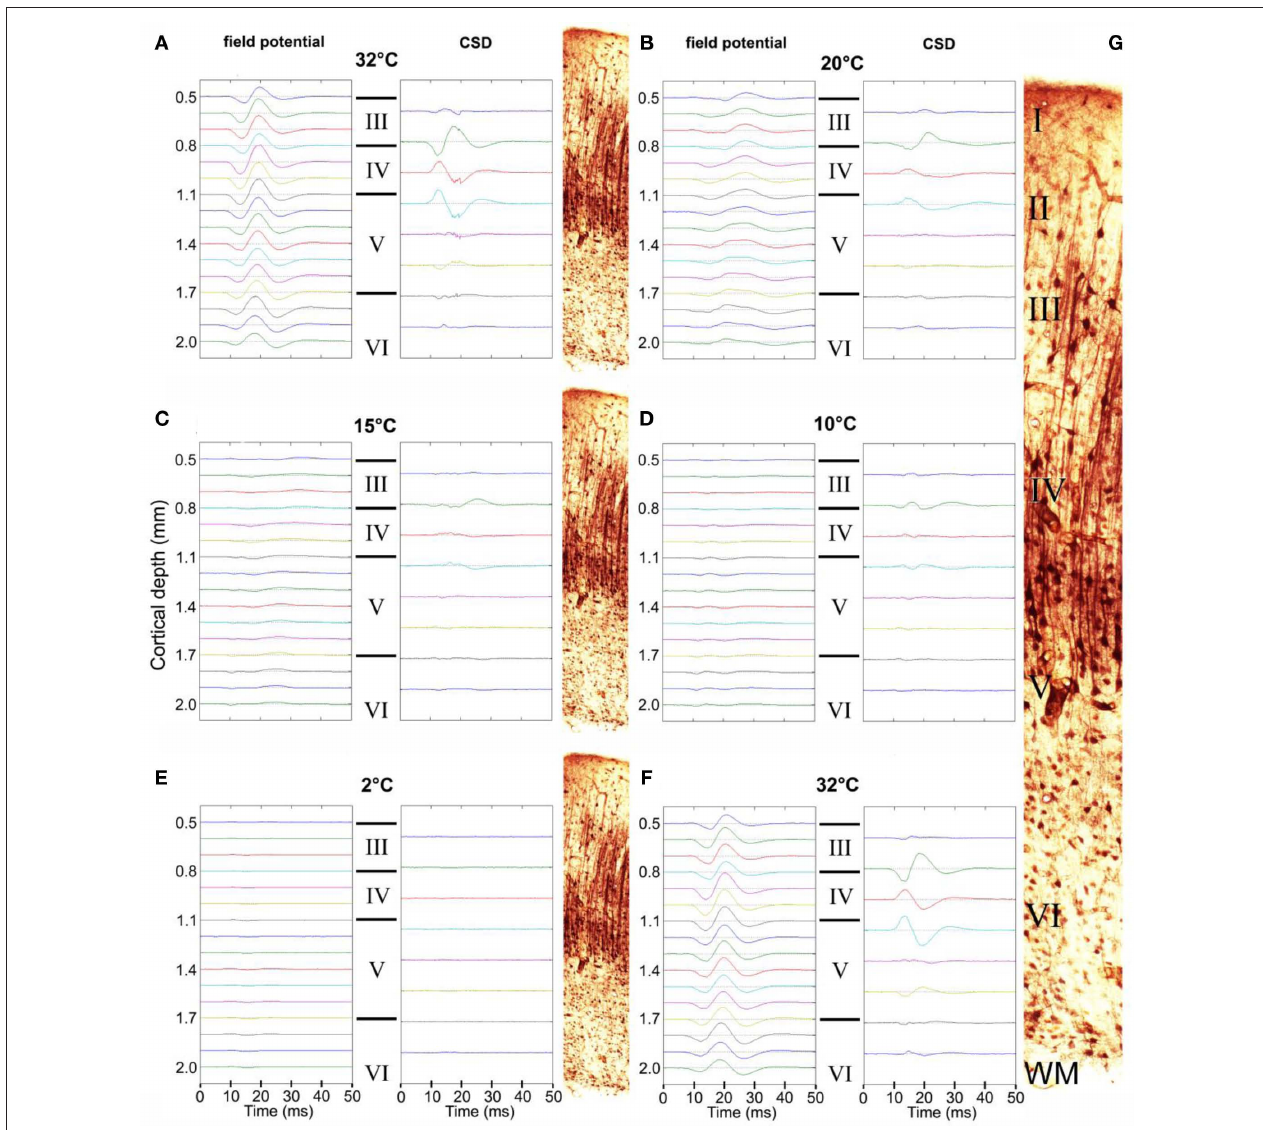
period. Corresponding CSD plots are shown alongside. The approximate layer of each field potential recording/CSD is also indicated (III, IV, V, or VI) and illustrated by the thallium-labeled sections shown. (g) Enlarged thallium-labeled section indicating approximate